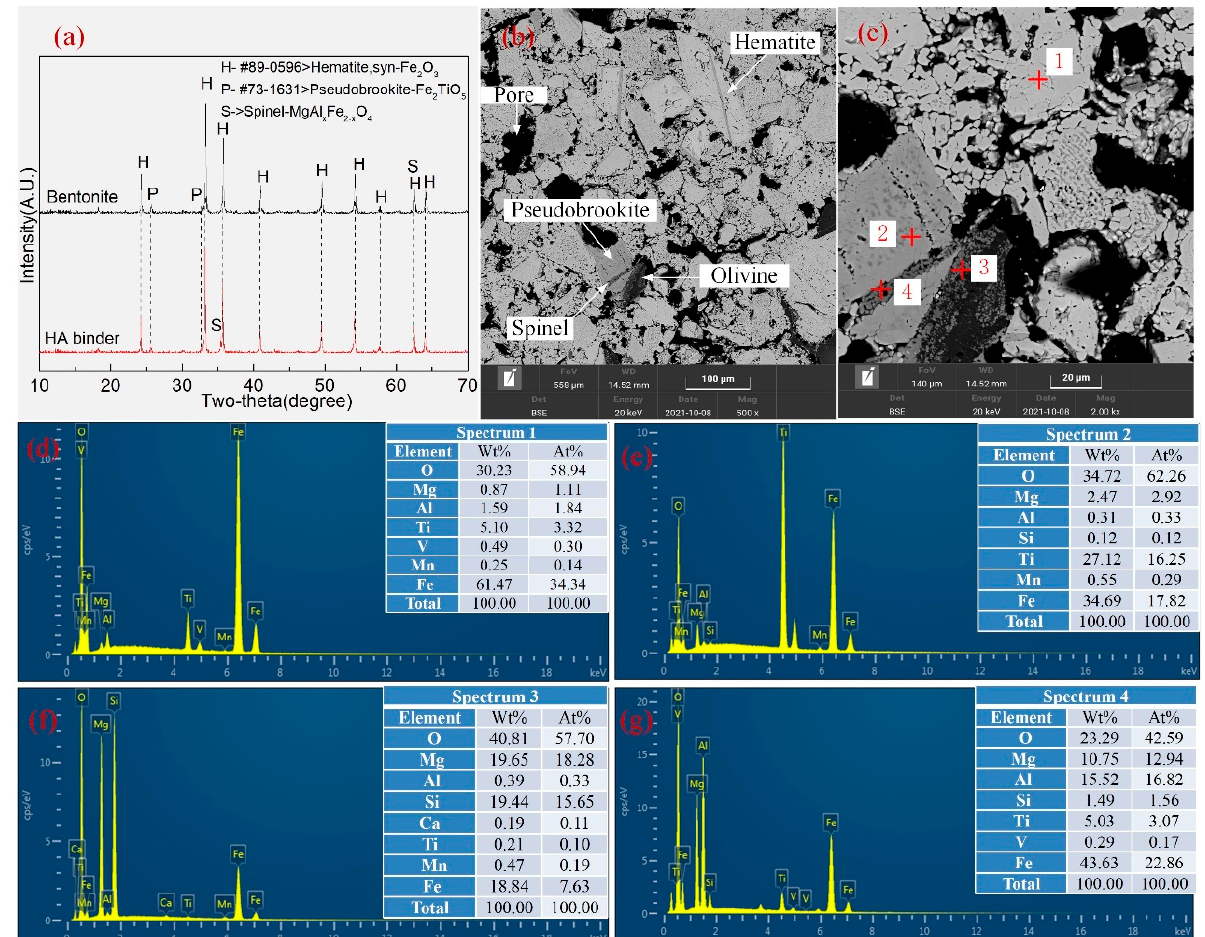
Figure 7. ( a ) XRD patterns of fired VTM pellets obtained using HA and bentonite binders. ( b – g ) SEM-EDS analysis of fired VTM pellets obtained using HA binder.